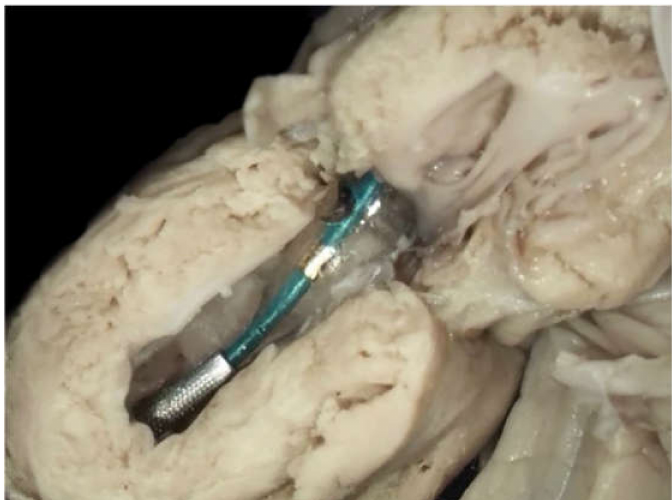
Figure 1. Training on the cardiac specimen in the dissection room. The catheter was introduced through the apex into the heart of the neonate with critical aortic stenosis. The guidewire with a balloon catheter was introduced through the left ventricular apex and the aortic